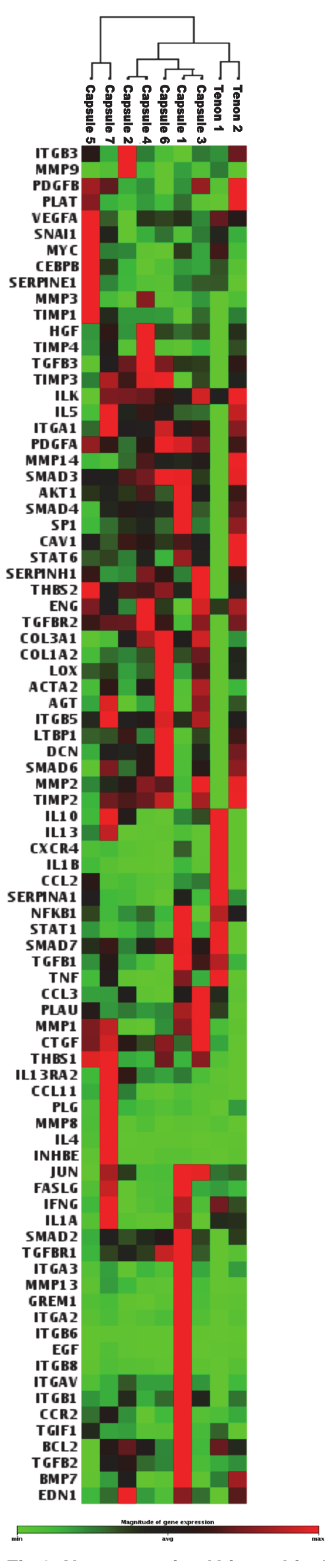
PLOS ONE | DOI:10.1371/journal.pone.0122409 April 16,